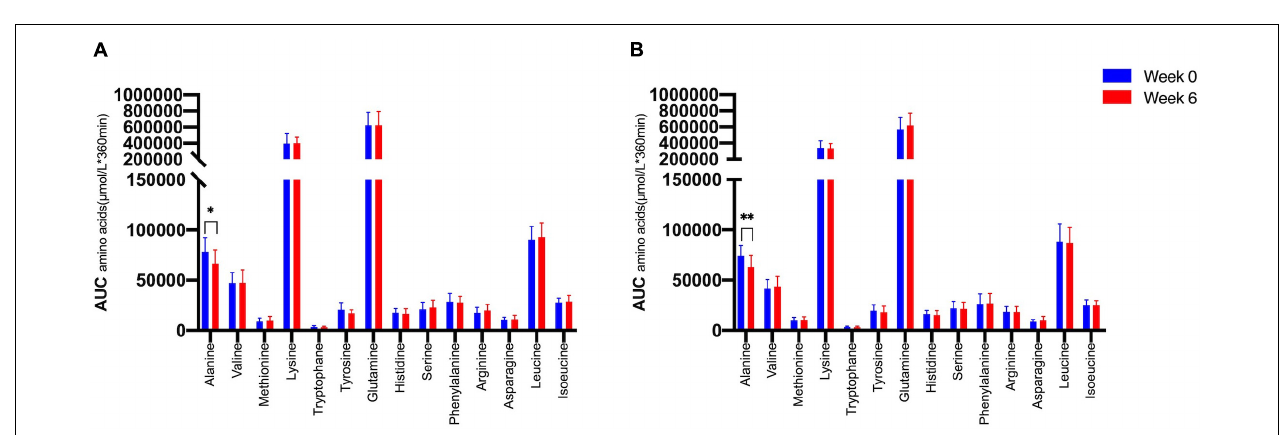
FIGURE 6 | Area under the curve (*360 min) of amino acids in the MMTTs between (A) lower IHL reduction group; (B) higher IHL reduction group before (Week 0, blue) and after the intervention (Week 6, red). ∗ p < 0.05; ∗∗ p <